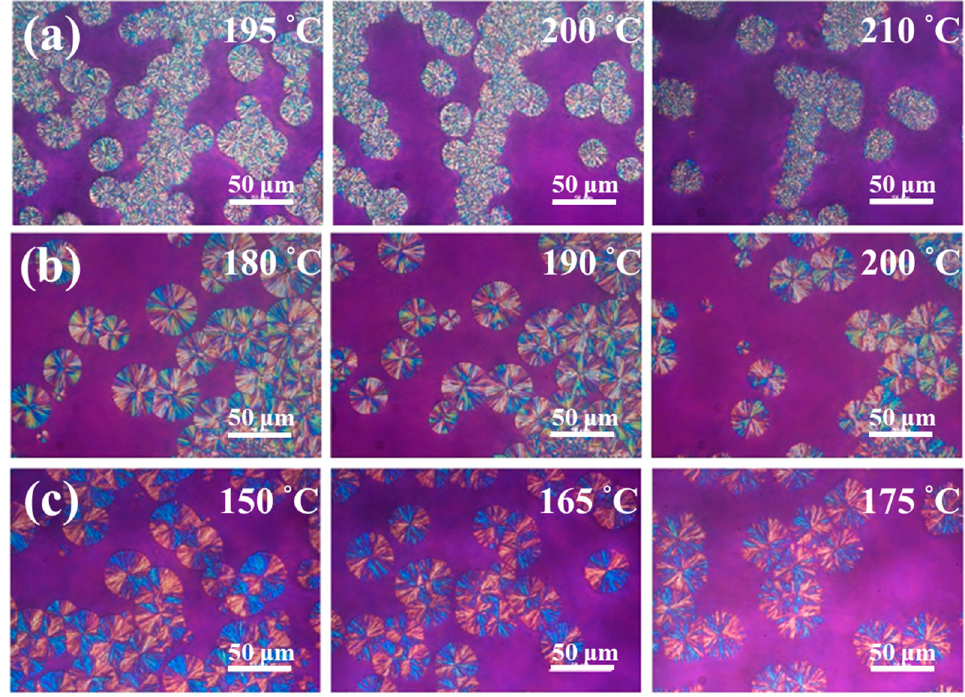
Figure 11. Polarizing light microscopy (PLM) image of PBT- co -PTMEG at the selected temperature: ( a ) PBT ( b ) PBT- co -PTMEG-10, and ( c ) PBT- co -PTMEG-40.